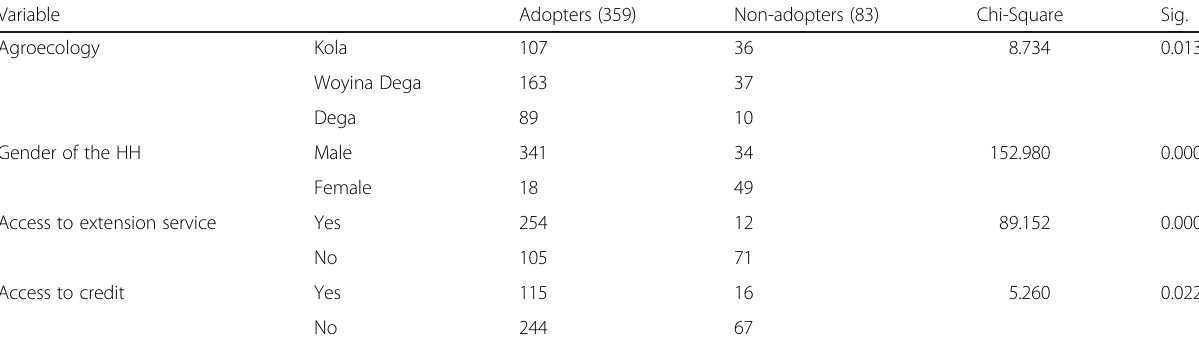
Table 2 Descriptive statistics of categorical variables used in regression